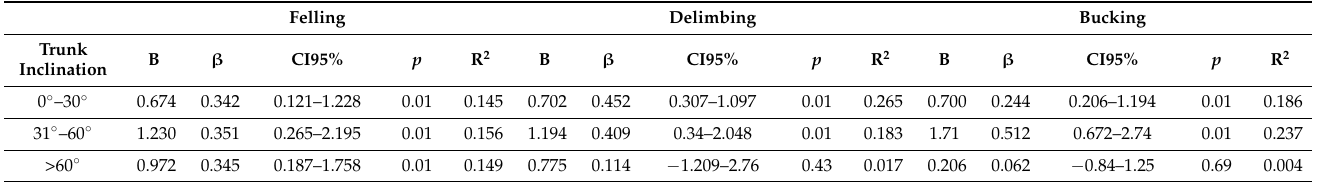
Table 6. Linear regression model: trunk inclination classifications as predictive variables associated with RCC in the total sample ( n = 40) for the three tasks of felling, delimbing, and bucking.